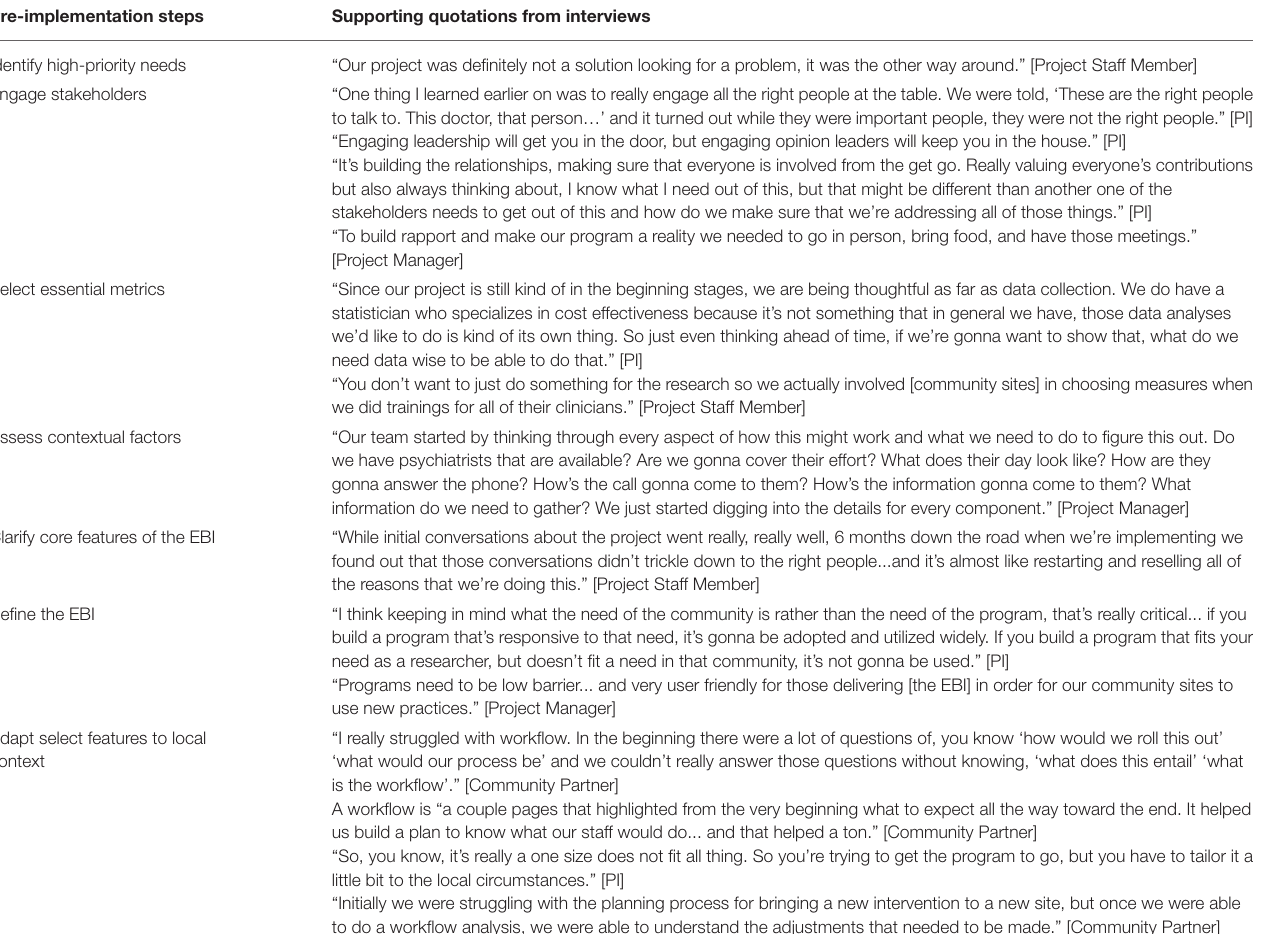
TABLE 4 | Pre-implementation illustrative